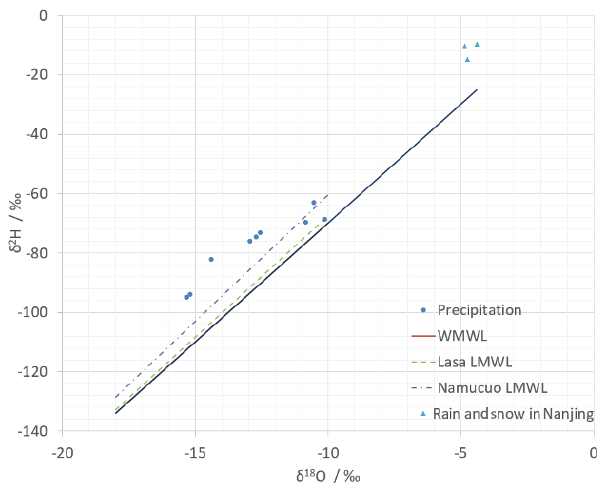
Figure 6. Rainfall and snow δ 2 H and δ 18 O isotopes.